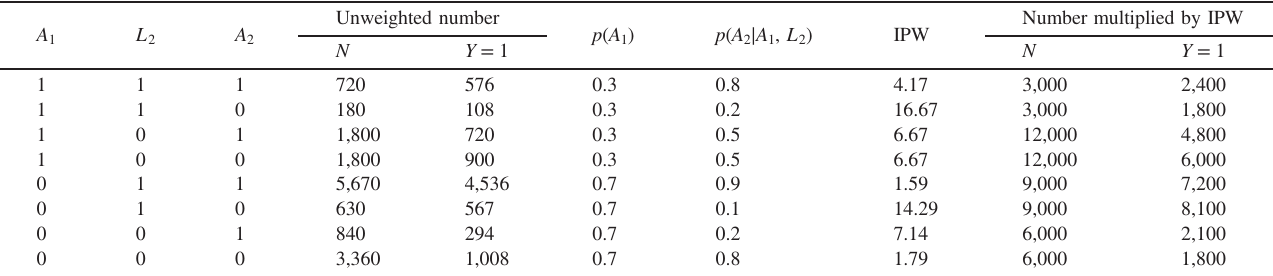
Table 4. Hypothetical cohort data weighted by inverse probability of